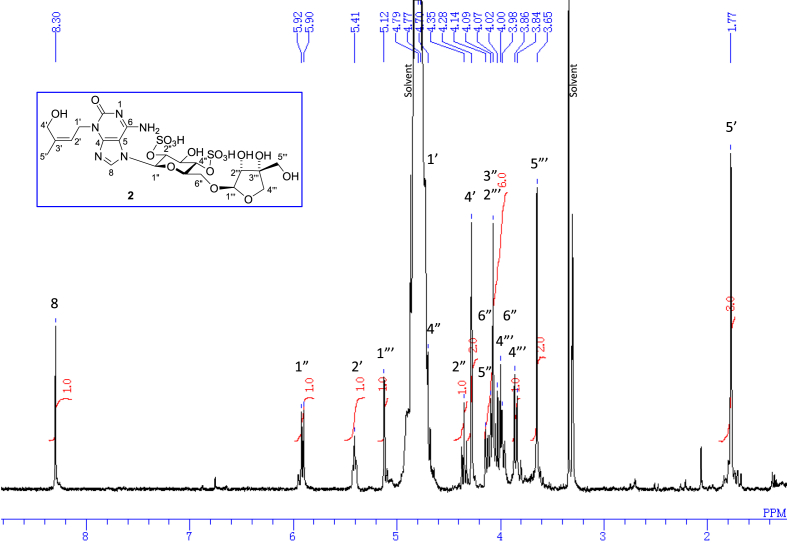
1H NMR (400 MHz, CD3OD–D2O, 1:9) of 2.